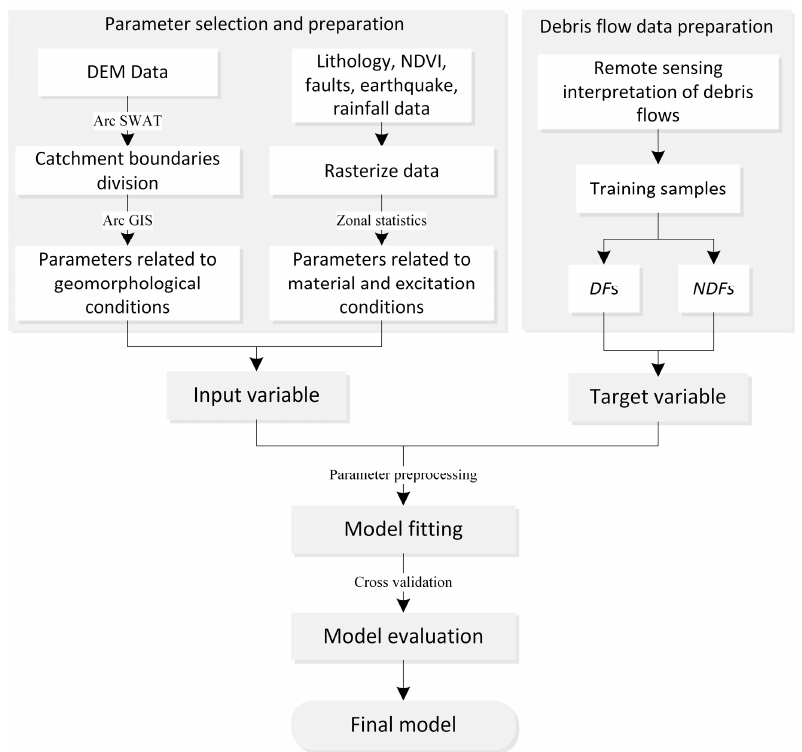
Figure 2. Modeling flow chart. (Note: DFs indicate debris flow catchments, and NDFs indicate non-debris flow catchments).